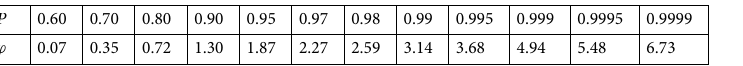
Table 3. Reference table of the assurance coefficient of the Gumbel curve with an extreme type I distribution.